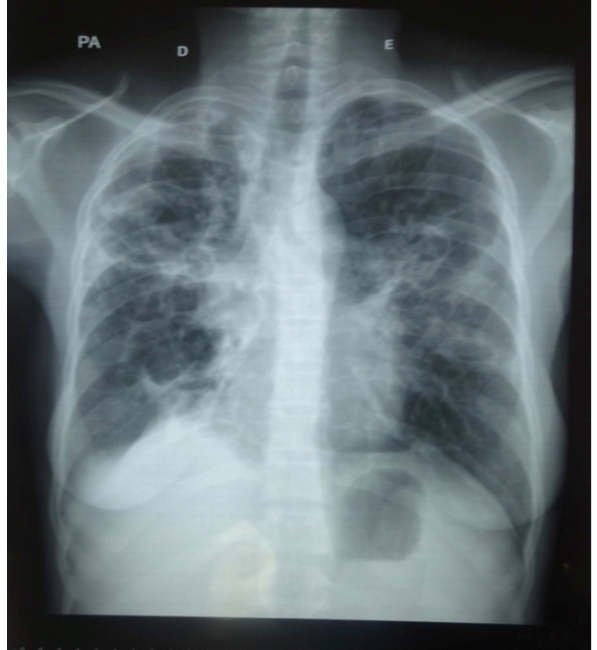
Figure 5. X-ray of a PTB patient showing a thick-walled cavitary lesion with pleural thickening in the right upper lung lobe at EOT having an elevated Aspergillus -IgG antibody titer of 174